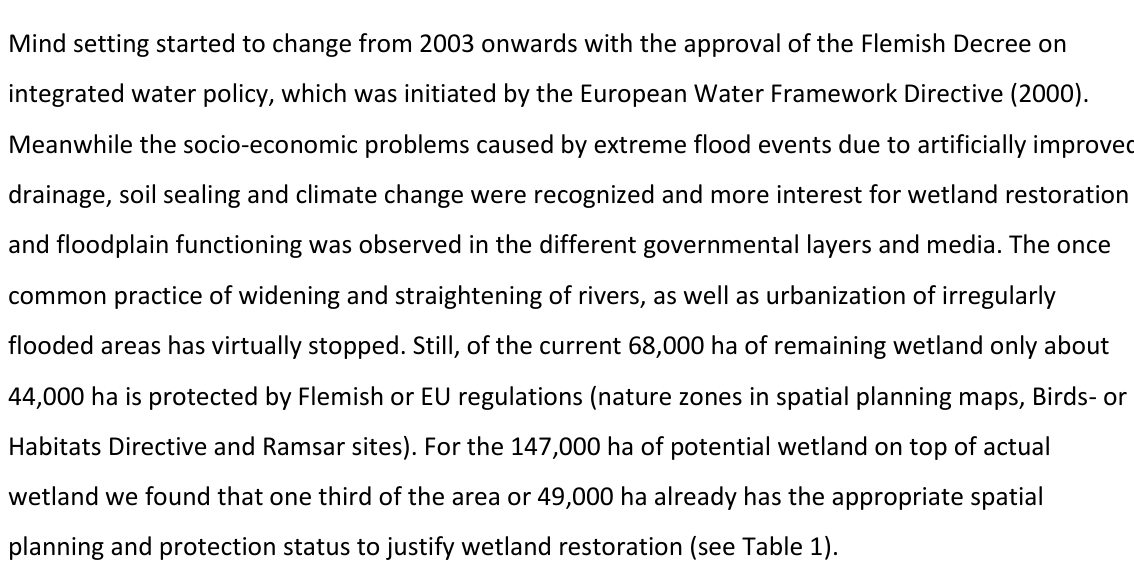
Table 1. Spatial planning and protection status of actual and two scenarios of potential wetlands in Flanders for several categories of wetlands (in ha). Note that for shallow and deep waters values are identical because no potentials could be